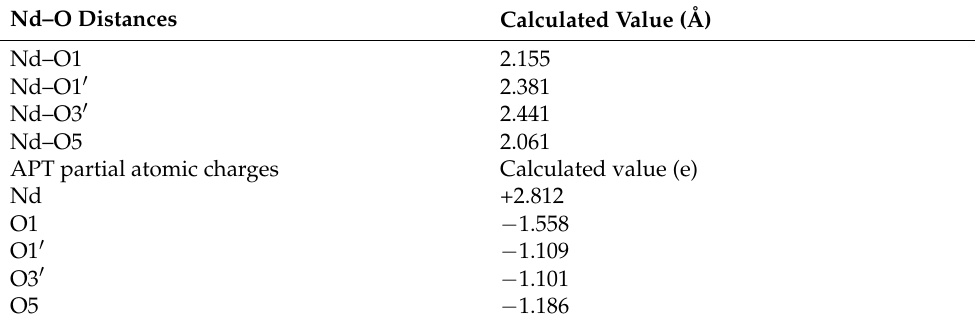
Table 1. Calculated Nd–O distances and APT partial atomic charges of the Nd(III) complex of orotic acid at the B3LYP/cc-pVDZ(SDD) level of theory.